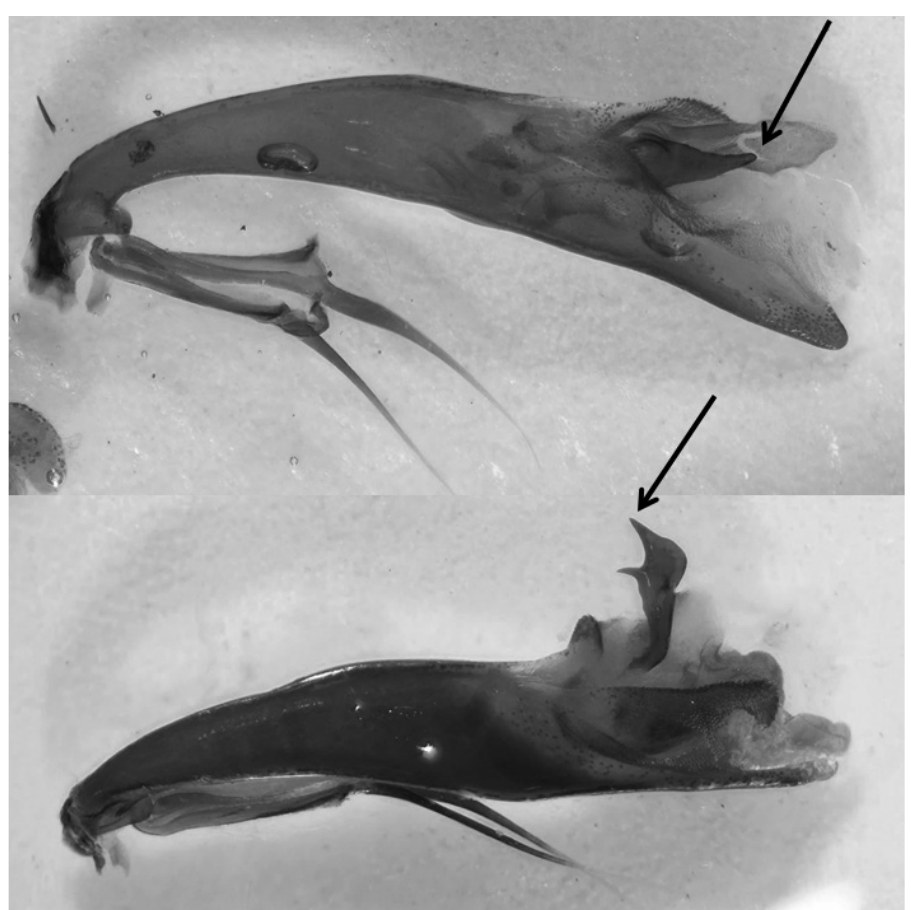
Figure 42. Copulatory pieces (arrows) of the median lobes of aedeagi of Calomera aulicoides (above) and C. littoralis winkleri